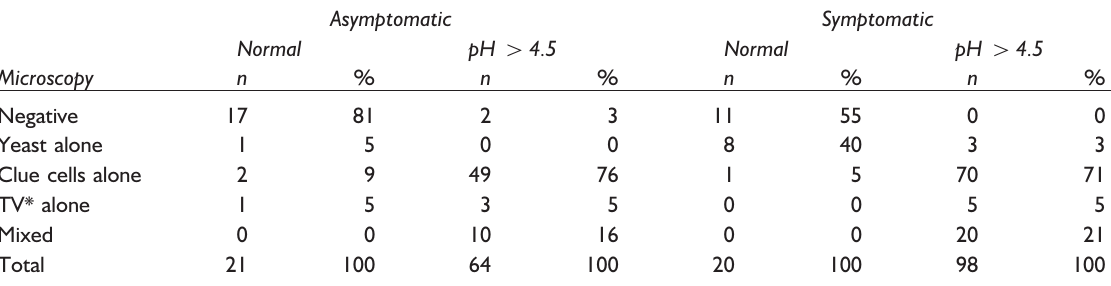
Table 2 Symptoms, vaginal pH and wet-mount microscopy